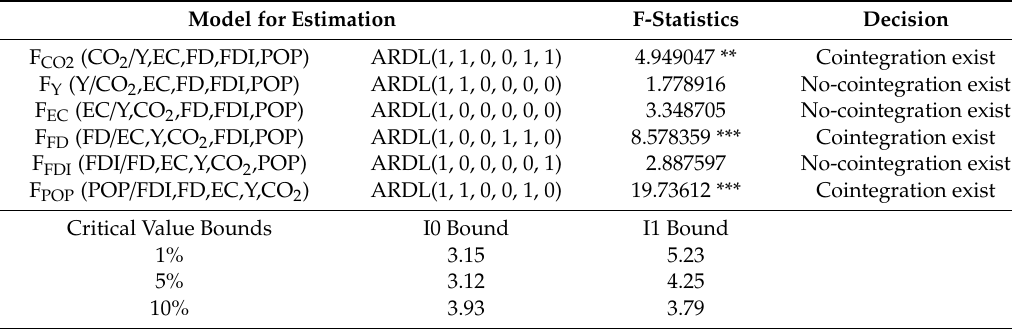
Table 5. Results of cointegration bounds